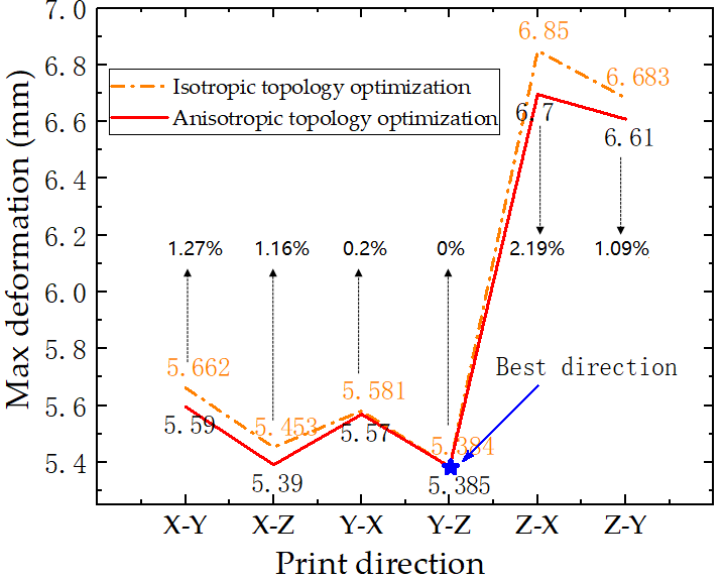
Figure 16. Deformation comparison between anisotropy and isotropy (yellow line is the deformation in six directions after isotropic optimization; red line is the deformation in six directions after anisotropic optimization) .